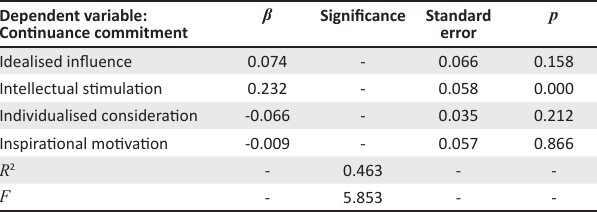
TABLE 7: Transformational leadership style constructs as predictors continuance commitment. Dependent variable: Continuance commitment